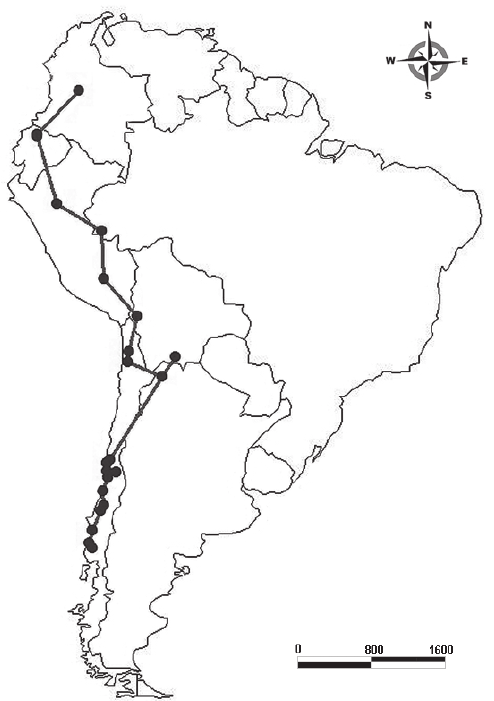
Fig. 1 - Individual track of Cuvieronius hyodon .